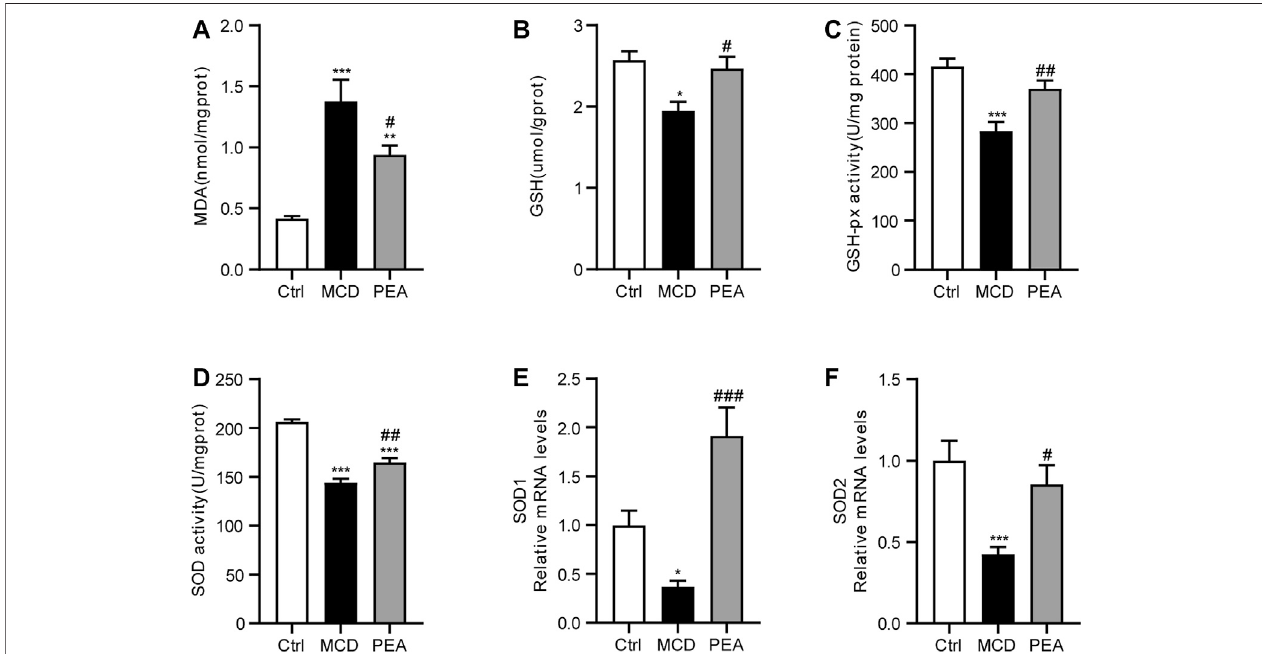
FIGURE 3 | MCD-induced hepatic oxidative stress was alleviated in mice treated with PEA. (A) Levels of hepatic MDA, (B) levels of hepatic GSH, (C) activity of hepaticGSH-px,and (D) activityofhepaticSOD, (E) SOD1,and (F) SOD2mRNAexpressioninliver.Ctrl:themicetreatedwithstandarddiet;MCD:themicetreatedwith MCD diet;PEA:themice treatedwithMCDdietandPEA.Valueswereexpressed asthemean ± SEM, n (cid:1) 6 – 8foreach group.* p < 0.05,** p < 0.01,*** p < 0.001versus the Ctrl group; # p < 0.05, ## p < 0.01, ### p < 0.001 versus the MCD group.